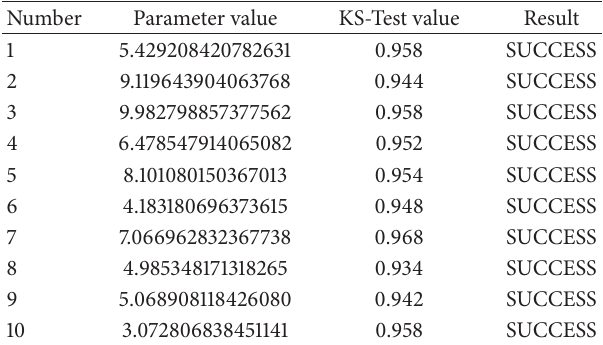
Figure 5: The attractor of the 𝑓 𝑟 map for 𝑟 = 7 .